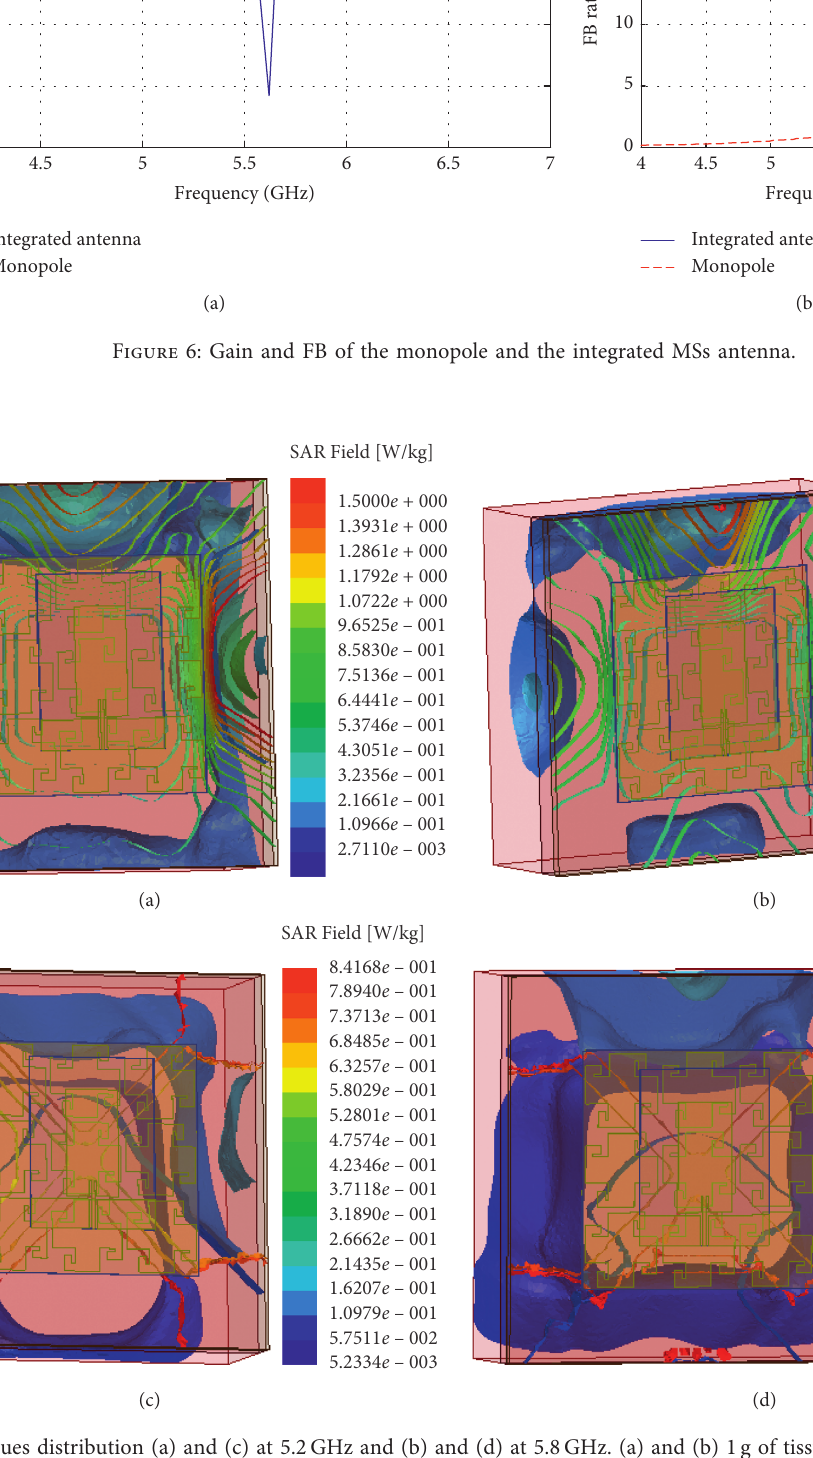
Figure 7: SAR values distribution (a) and (c) at 5.2GHz and (b) and (d) at 5.8 GHz. (a) and (b) 1g of tissue. (c) and (d) 10g of